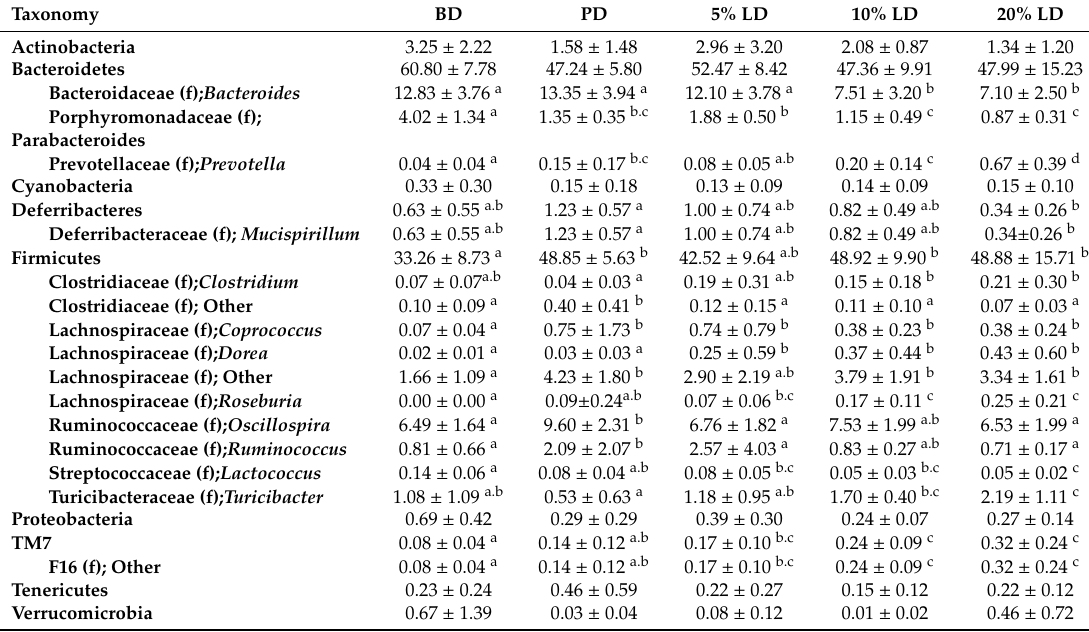
Table 2. Relative abundance of fecal microbial community members (phylum and genus level) in BD-, PD-, 5% lentil-, 10% lentil- or 20% lentil-fed